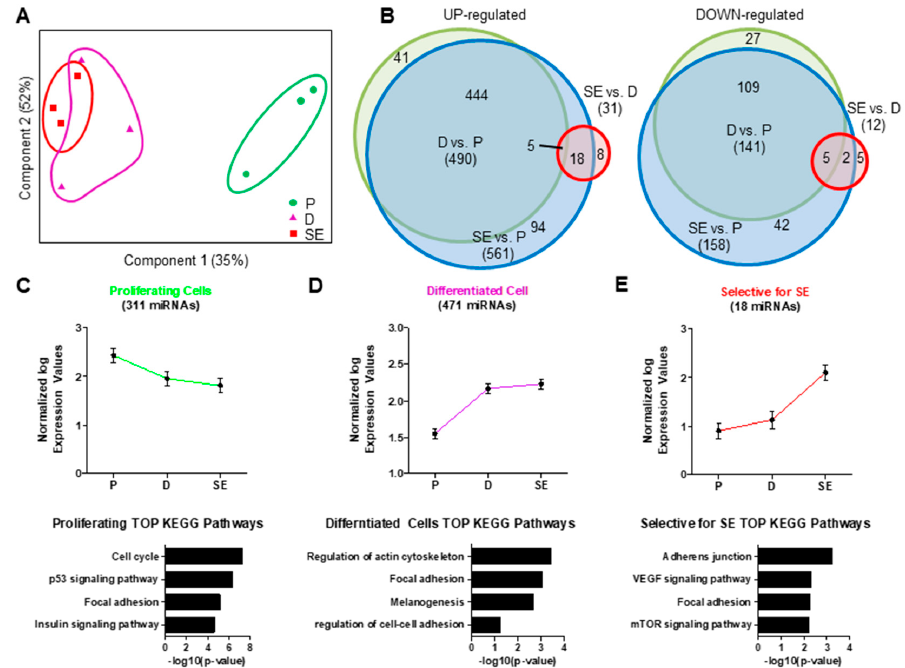
Figure 2. Dynamic regulation of miRNA expression during keratinocyte differentiation. ( A ) Samples are displayed with respect to the first two components and are clustered according to their differentiation state (P proliferating monolayer; D, differentiated monolayer; SE, skin equivalent). P cells can be clearly separated from D and SE indicating differences in global miRNA expression patterns. Differentiated keratinocytes cultures in monolayers and in SE cannot be clearly separated in the PCA plot. ( B ) Venn diagrams showing the overlap of up- and downregulated miRNAs with significant changes in expression between the three conditions. The area of the circles corresponds to the number of differentially expressed miRNAs. The greatest alterations were observed in miRNA expression between P keratinocytes and SE. ( C ) One cluster (green) characterizes miRNAs repressed during differentiation, ( D ) one cluster (violet) shows miRNAs upregulated during keratinocyte differentiation in monolayer and SE and ( E ) one cluster (red) shows miRNAs exclusively upregulated in SE. KEGG pathway analysis shows that miRNAs targeted mRNAs of cluster are significantly associated with cell cycle, while genes of the second and third clusters are associated with the cytoskeleton and cell adhesion, respectively. n = 3.